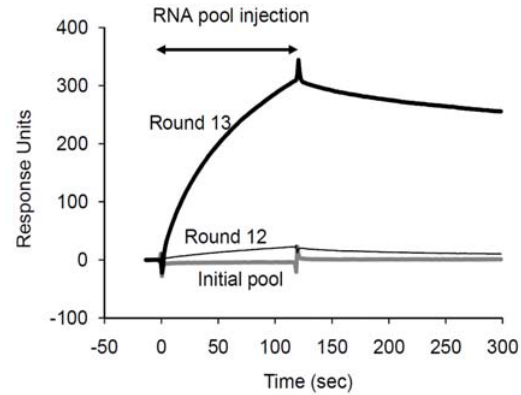
Figure 2. Binding analysis of the selection pools using SPR. The interactions between the selection pools (round 0, 12, 13) and the immobilized SPC on a SA sensor chip were investigated. The concentration of each pool was adjusted to 2 µM in the selection